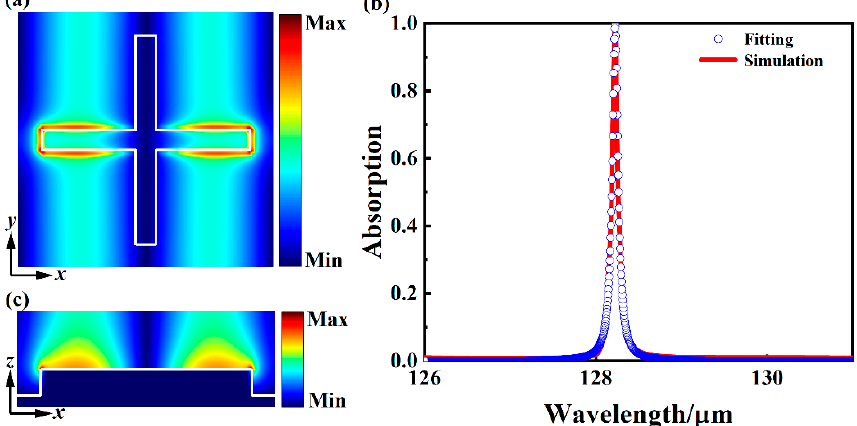
Figure 4. The electric field (| E |) distribution of the absorber in the x - y plane ( a ) and x - z plane ( c ) at the resonant wavelength. ( b ) Simulated (red curve) and fitted (blue dots) absorption spectra of the proposed absorber. In ( a , c ), the outline of the absorber is indicated by the white lines, and the polarization direction of the incident wave is along the x -axis.